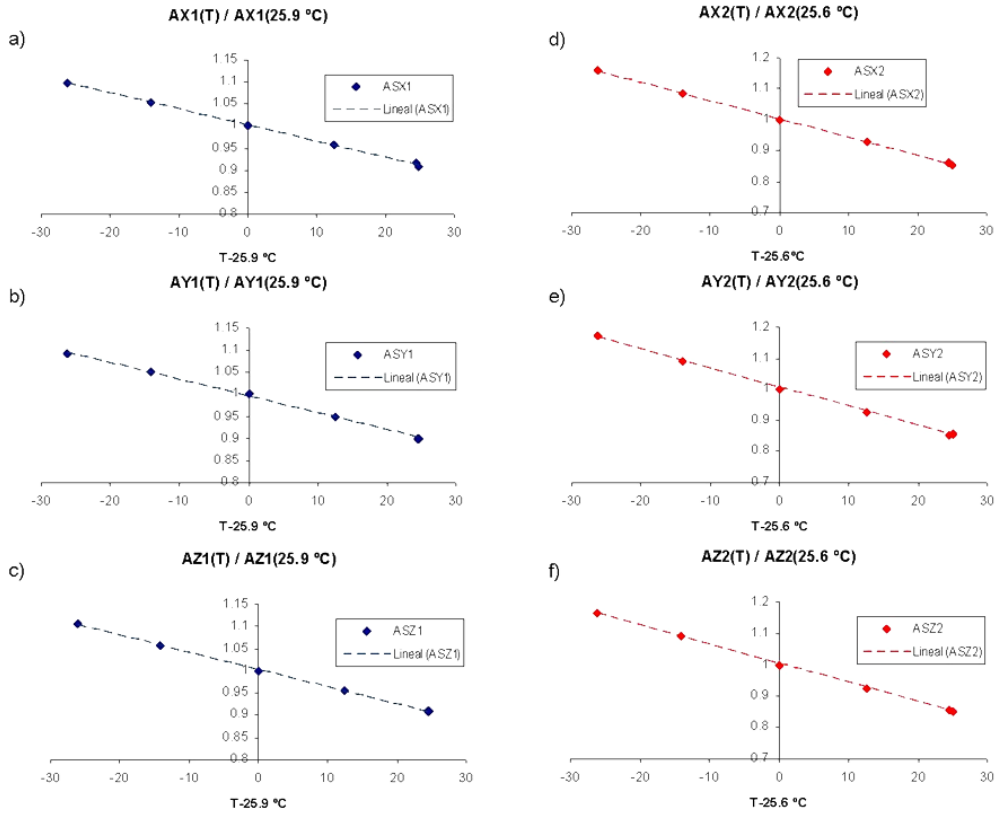
Figure 9. Normalized amplitude as a function of modified temperature for axis sensor (a) X1, (b) Y1, (c) Z1, (d) X2, (e) Y2, (f) Z2.